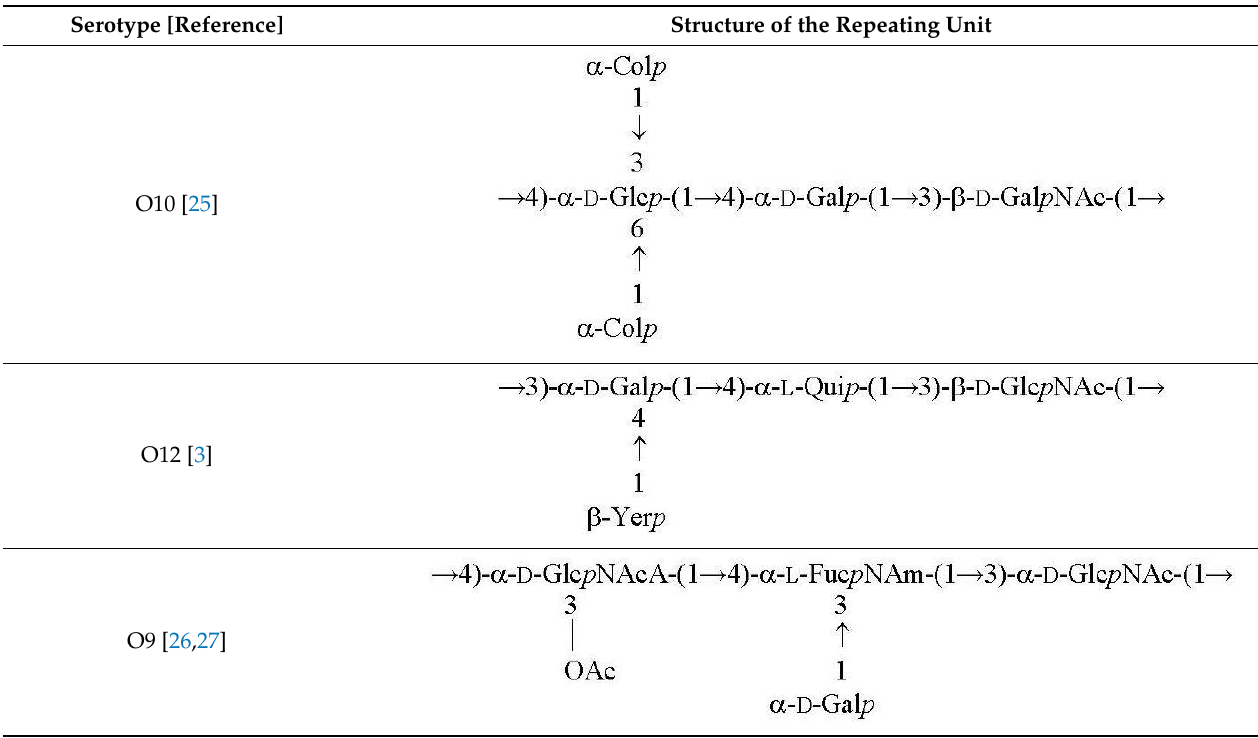
Table 2. Structures of the core oligosaccharides of Y. pseudotuberculosis/Y. pestis cultivated at various temperatures. Sub- stituents present in non-stoichiometric amounts are indicated in italics.